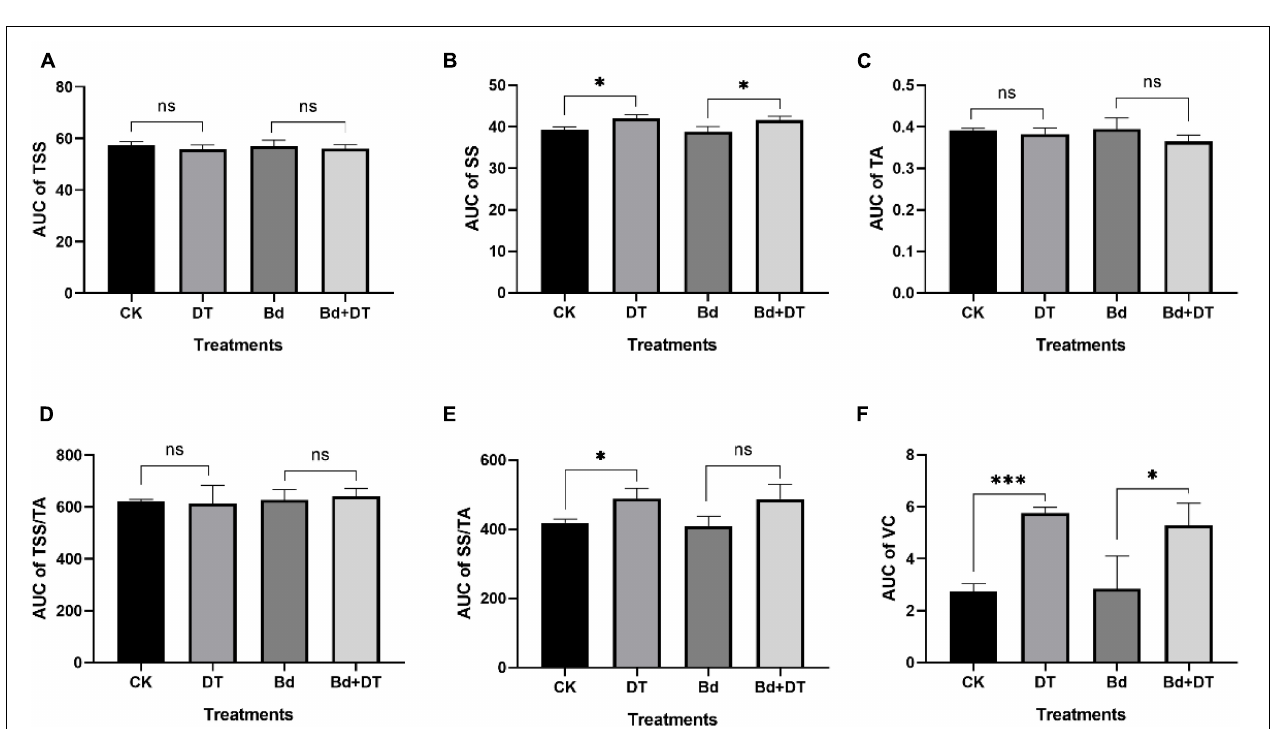
FIGURE 8 | The area-under-curve (AUC) of internal quality indexes including total soluble solid (A) , soluble sugar (B) , titratable acidity (C) , TSS/TA (D) , SS/TA (E) , and vitamin C (F) the different treatment fruit. ∗ P < 0.05, ∗∗∗ P < 0.001, ns P > 0.05.